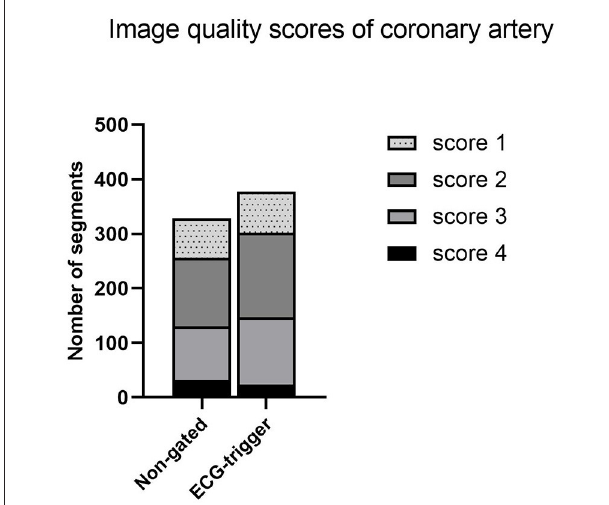
FIGURE 1 | Image quality scores of the coronary